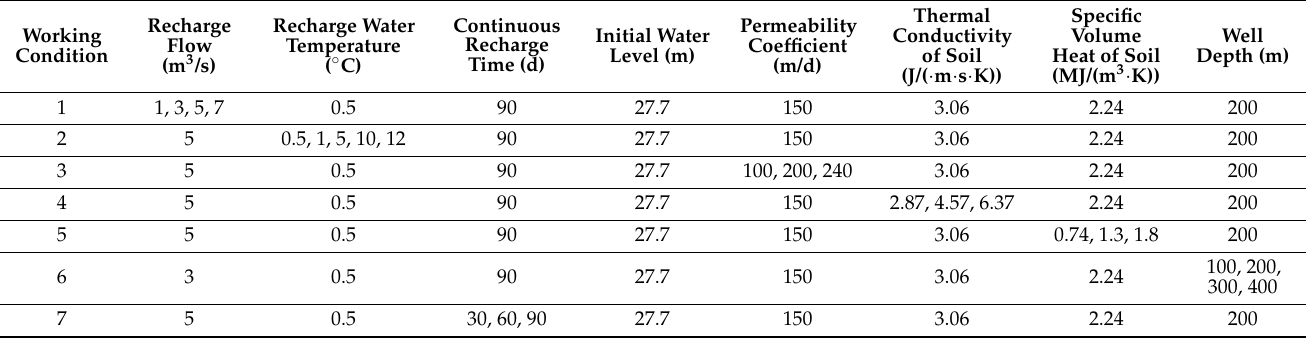
Table 6. Variation conditions of the recharge temperature field under different